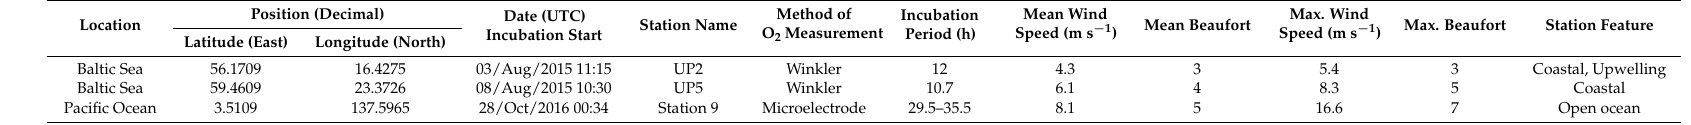
Table 1. Time of incubation of seawater samples, wind speeds and sea states during operation of the Surface In Situ